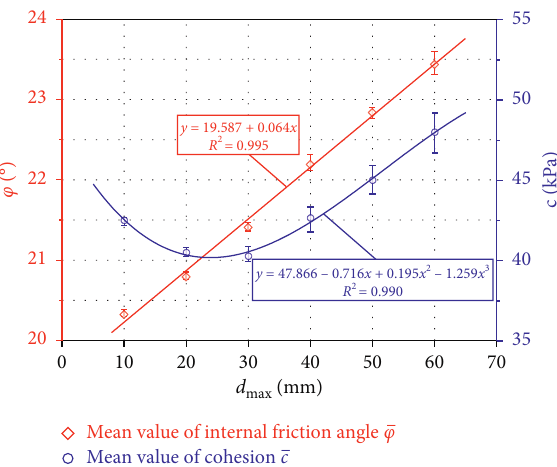
Figure 16: Relationship between d